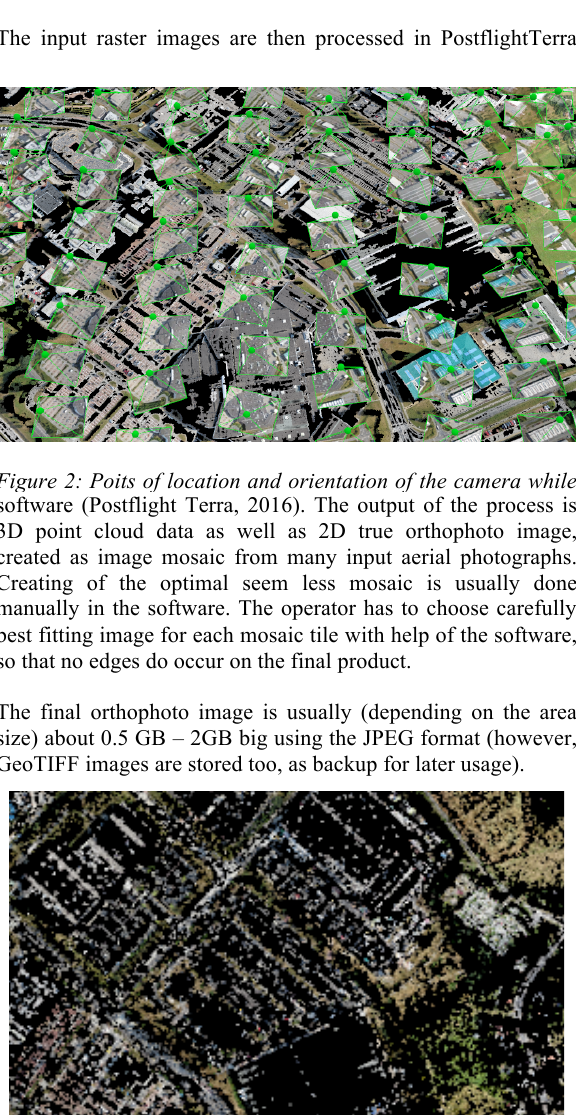
Figure 5: Tile schema for WMTS